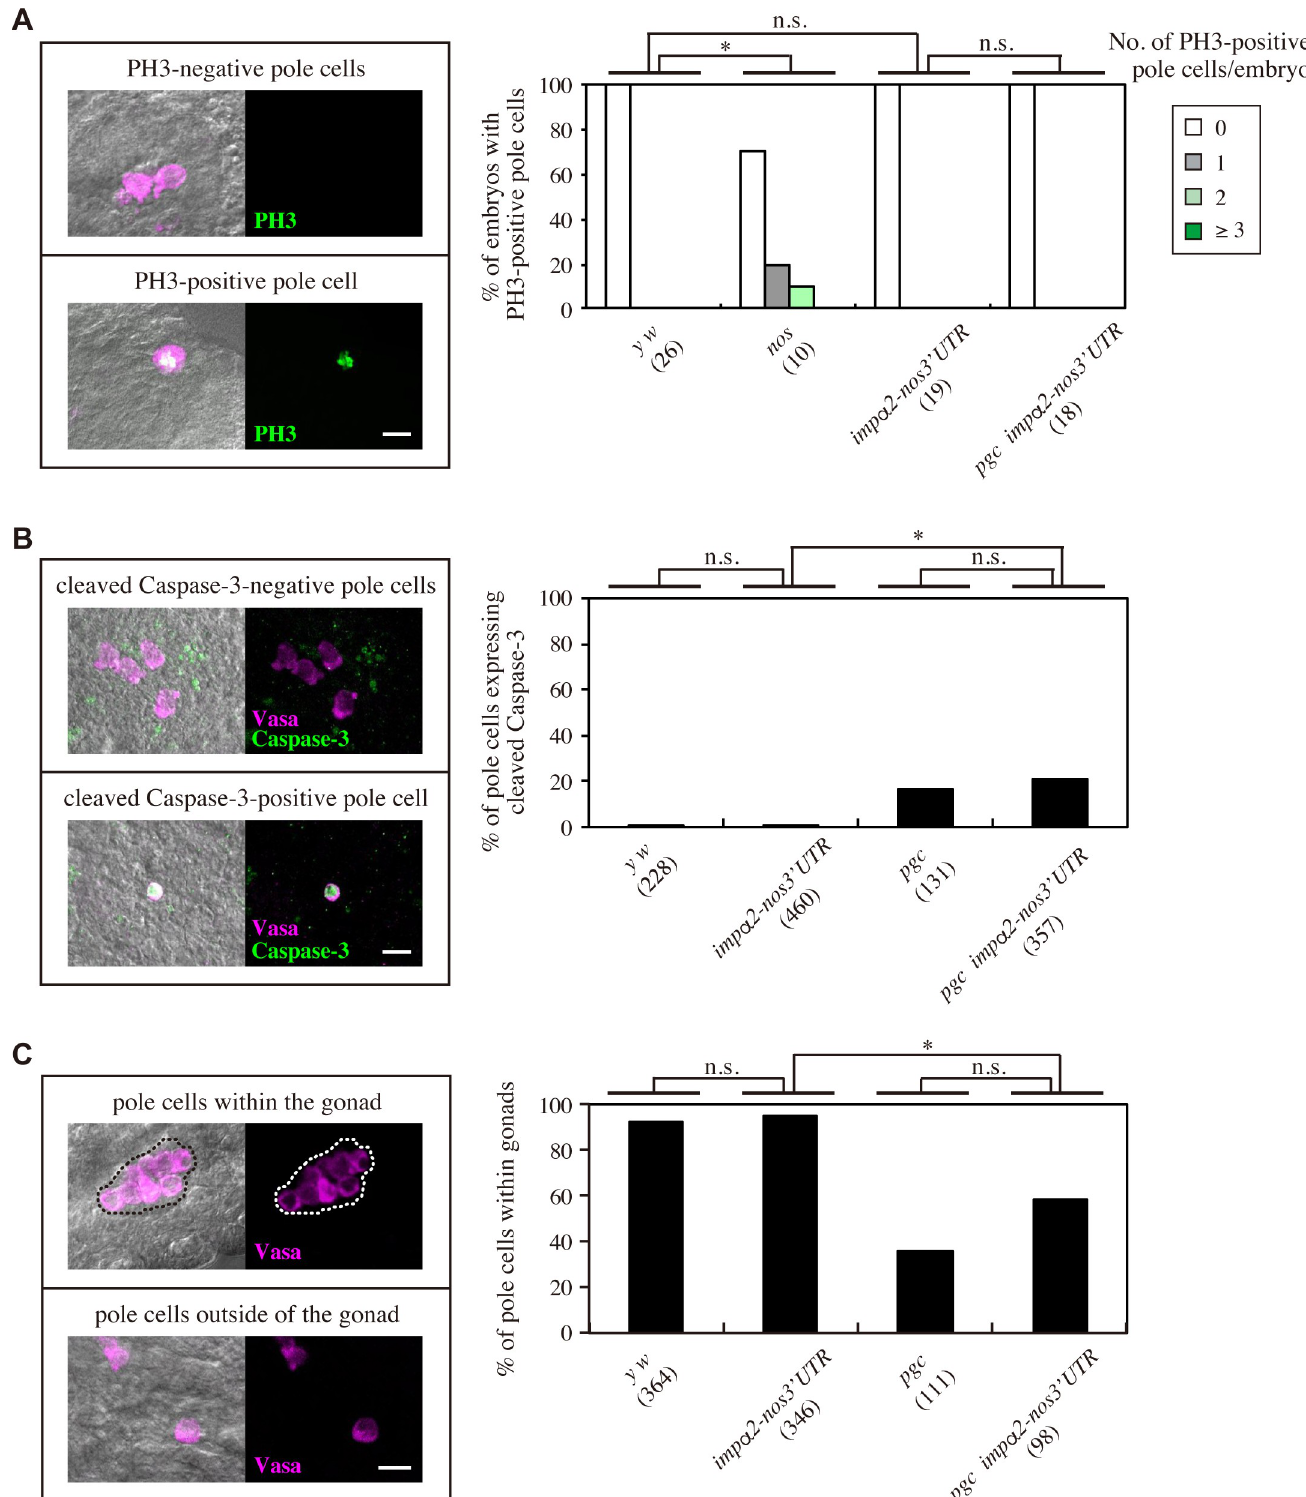
Fig 6. Mis-expression of Imp α 2 in pole cells has no significant effects on mitosis, apoptosis, or migration of pole cells. ( A ) Expression of a mitotic marker PH3 was examined in pole cells of embryos derived from y w , nos , imp α 2-nos3’UTR , and pgc imp α 2-nos3’UTR females mated with y w males. Stage-7–9 embryos were double-stained with anti-PH3 (green) and anti-Vasa (a marker for pole cells: magenta) antibodies. Left: representative images of pole cells negative (top) and